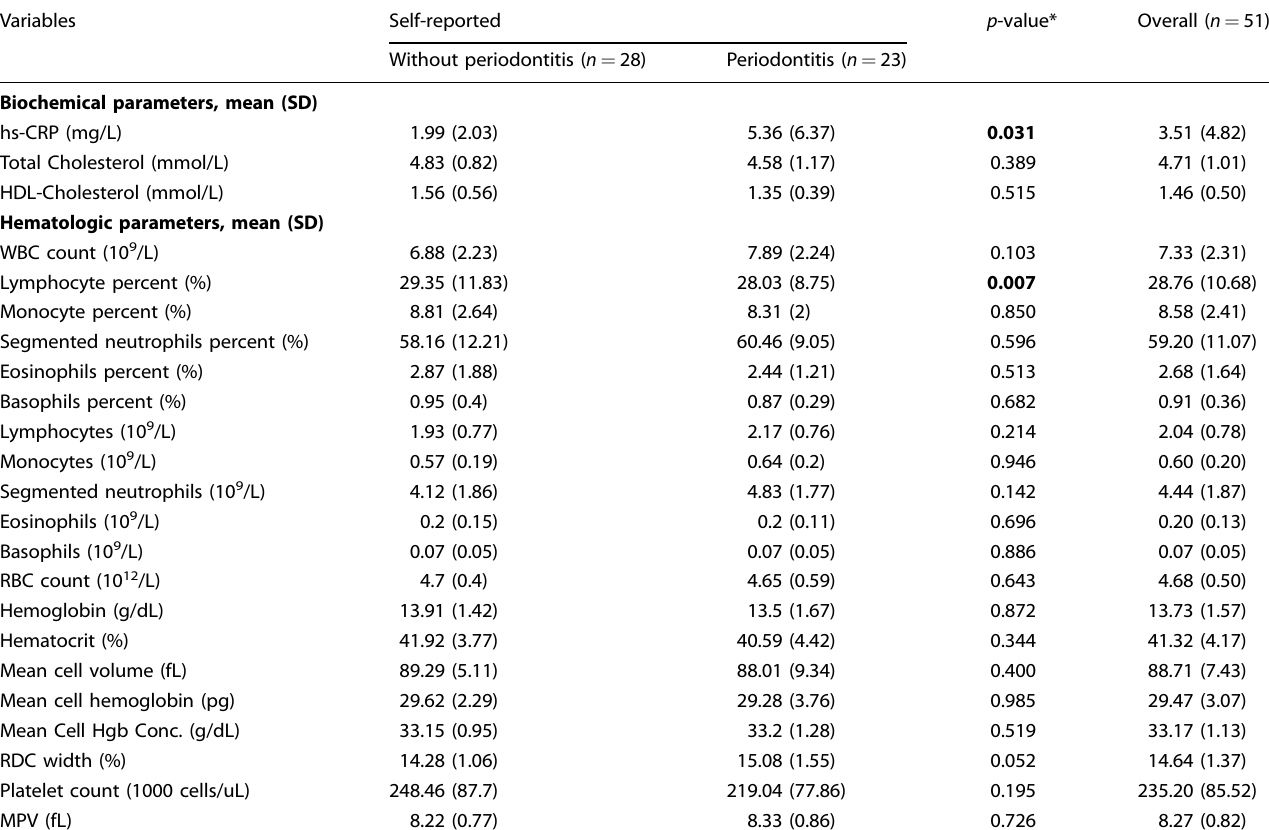
Table 2. Hematologic and biochemical levels of PD patients according to the self-report of periodontitis.